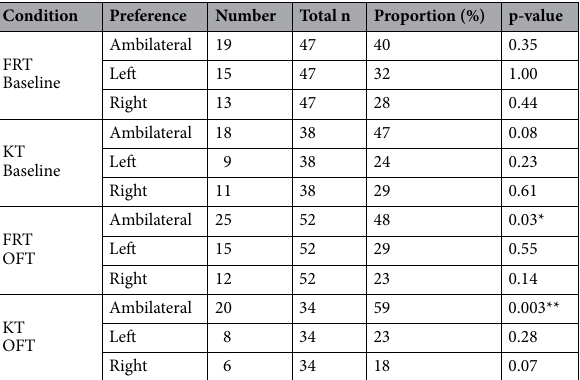
Table 1. The distribution of paw preferences in the Food-Reaching Test (FRT) and the Kong Test (KT) for the baseline and the stressful OFT condition. P-values indicated the p-value of a binominal test against equal distribution (proportion = 0.33333). Asterisks indicate p-values with *p < 0.05, **p < 0.01.